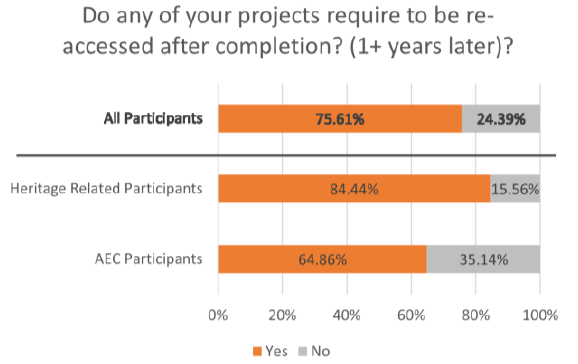
Figure 7: Need for future re-accessibility of digital data.